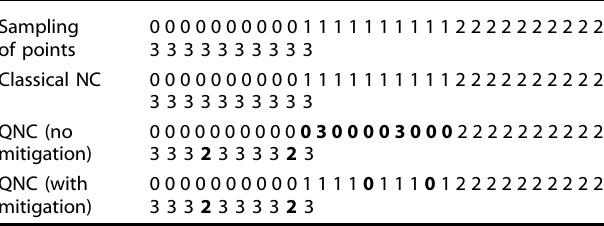
Table 2. Comparison of labels assigned by the different classi fi cation schemes for synthetic data with N q = 8, N c = 4, and N s = 1000.